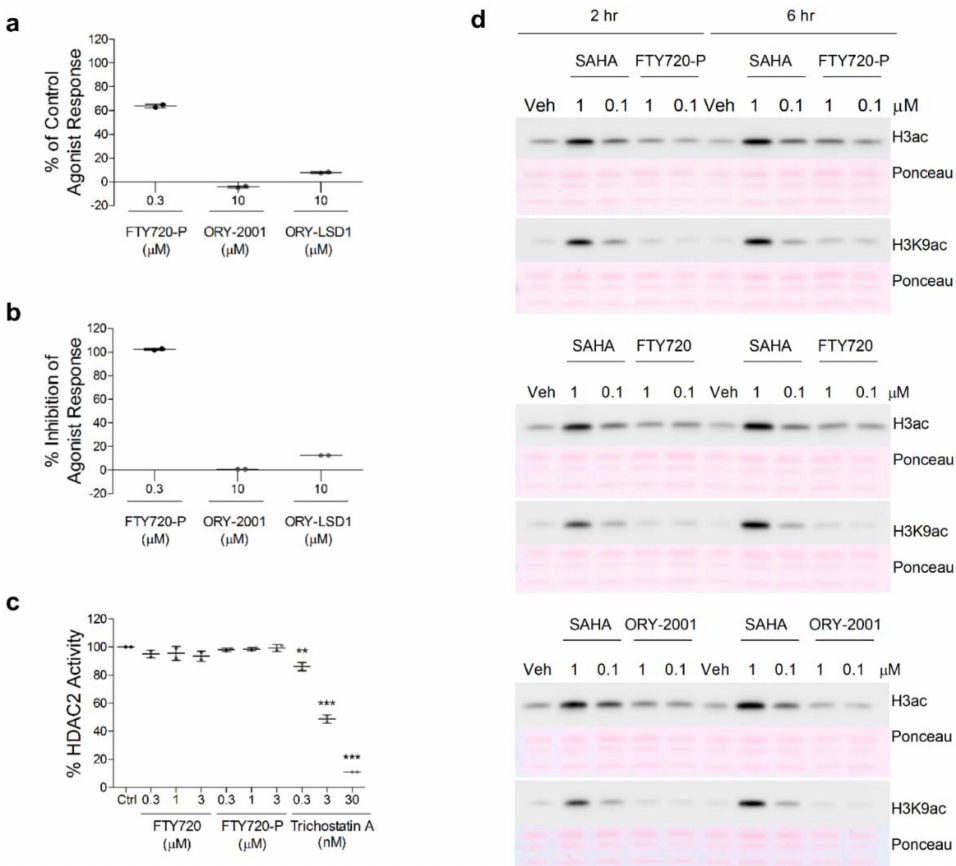
Figure 10. Effect of ORY-2001, ORY-LSD1, FTY720 and FTY720-P on S1PR and HDAC. Evaluation of the agonistic ( a ) and antagonist ( b ) effect of the compounds on the human S1P1 receptor. Data are expressed as the percentage of the impedance response of the control agonist (S1P at 0.3 µ M; EC 50 = 0.001 µ M), and as the percentage of impedance inhibition of the control agonist response (S1P at the EC 80 = 0.01 µ M), n = 2; ( c ) HDAC2 biochemical activity. Data are expressed as percentage of control (no compound) activity, n = 2. TSA was used as a control; ( d ) Cellular HDAC activity assay. H3 acetylation (H3ac) levels detected by Western blot analysis using global and H3K9-specific antibodies on cell extracts of SH-SY5Y cells after 2 (left) and 6 h (right) treatment with FTY720-P (top), FTY720 (center) and ORY-2001 (bottom) at 1 and 0.1 µ M. SAHA was used as a control. Ponceau S staining was used as loading control. Veh: Vehicle. Representative image of n = 3 ( n = 4 for global H3ac and n = 1 for H3K9ac). ** p < 0.01, *** p < 0.001 between vehicle and treated sample.